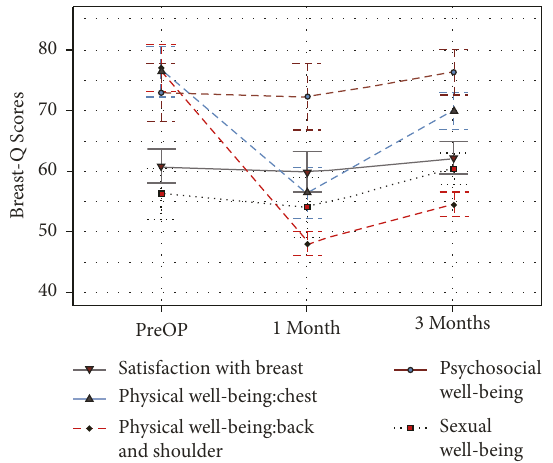
Figure 8: The trends of the BREAST-Q scores for breast satis- faction and quality of life before and after the